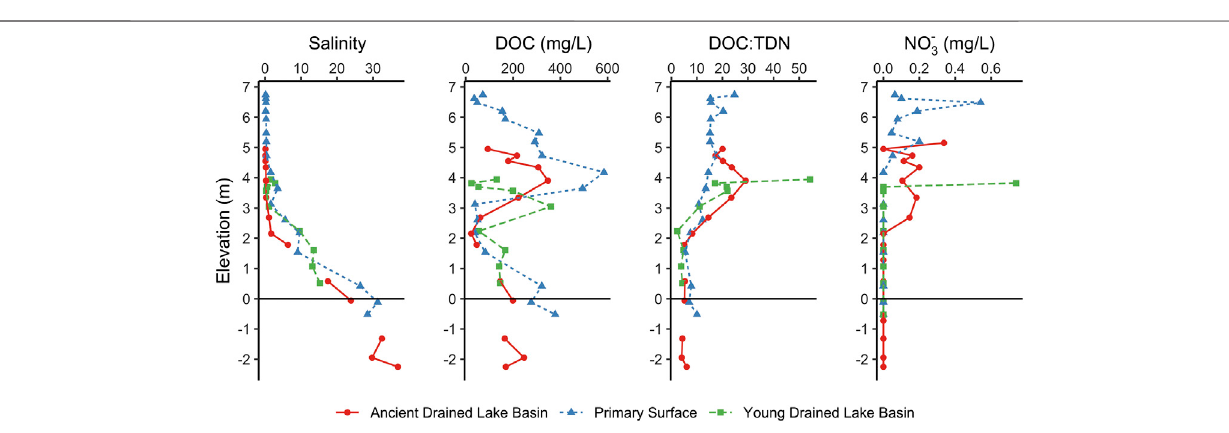
Frontiers in Earth Science |